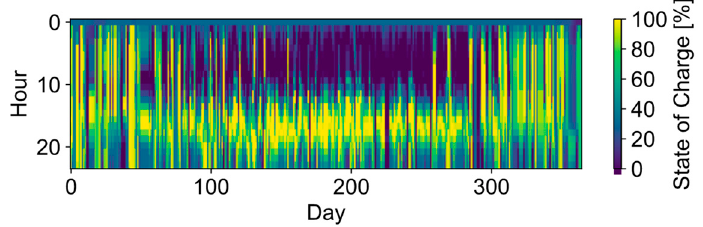
Figure A1. Case study 2—Battery storage operation for 40 typical days (level 1).